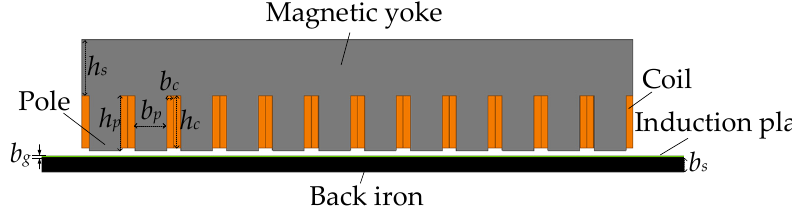
Figure 3. FEA model of eddy current braking.